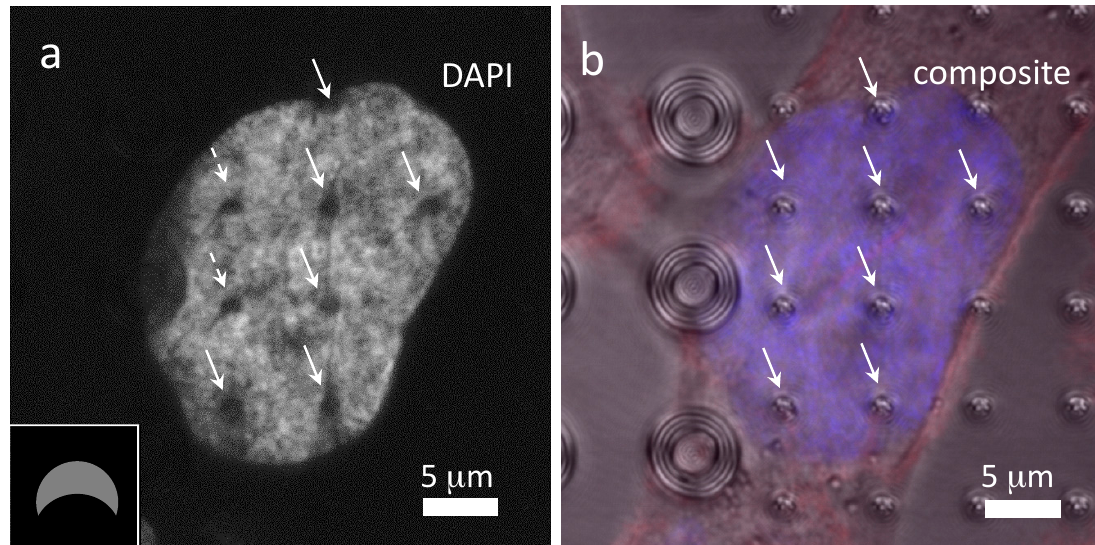
Figure 7. ( a ) DAPI only and ( b ) composite top-down micrographs of a cell adhered on small C-shaped and hollow pillars. The locations of the pillars are highlighted with arrows. Cells were incubated on the pattern substrate for 72 h. Inset drawing indicates the pillar orientation.